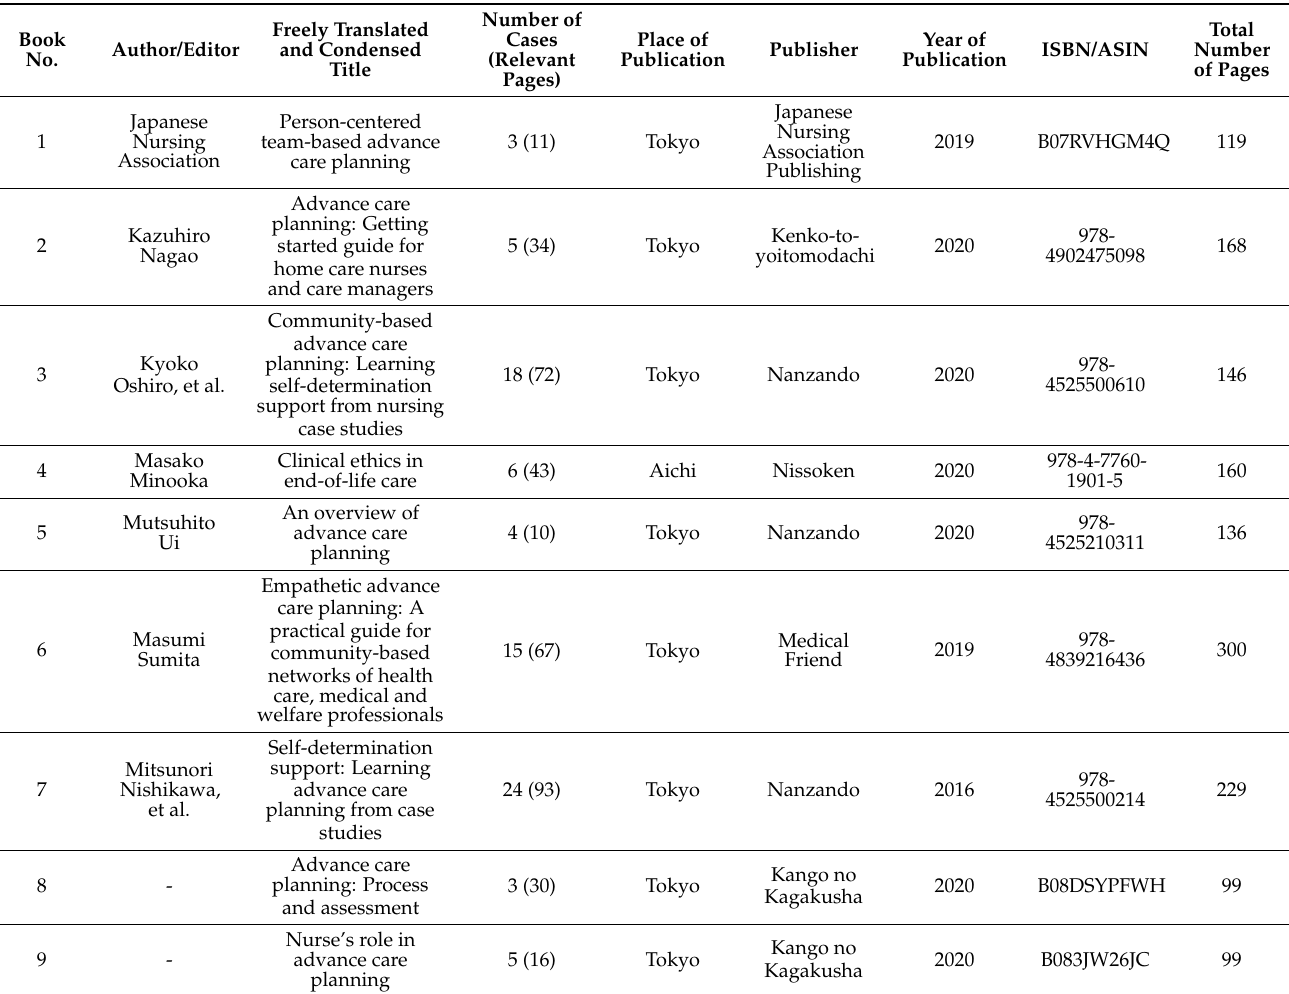
Table 1. Details of books analyzed in this